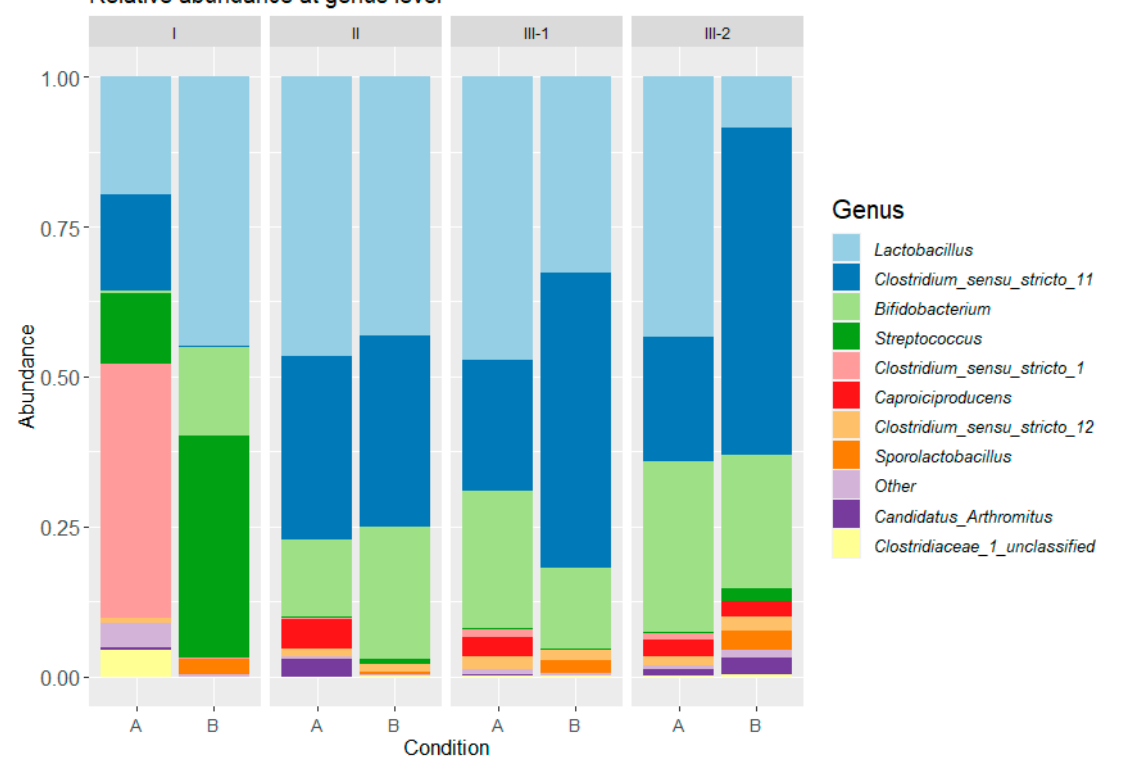
Figure 4. Relative bacterial community abundance (%) in A and B conditions during the periods I (day 2), II (day 5), III-1 (day 8), and III-2 (day 12). During period I, microbial community in condition A was dominated by 42% Clostrid- ium_sensu_stricto_1 followed by 19% Lactobacillus sp. and 16% Clostridium_sensu_stricto_11 . In total, Clostridium sp. represented 59% of the community, which is consistent with the high H 2 production observed. In comparison, during the stress period (I), in condition B, the microbial community was only composed of 0.3% Clostridium sp. and was dominated by 44% Lactobacillus sp., 37% Streptococcus sp., and 15% Bifidobacterium sp. These genera